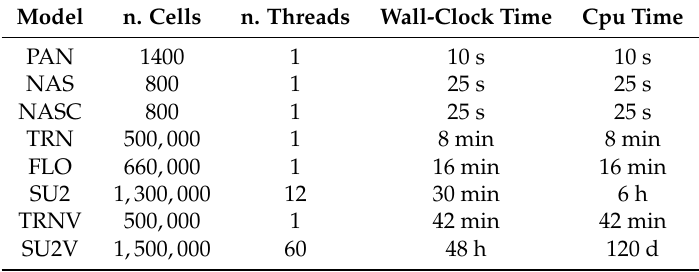
Table 8. Mesh size and computational time required by the different models for the Embraer benchmark